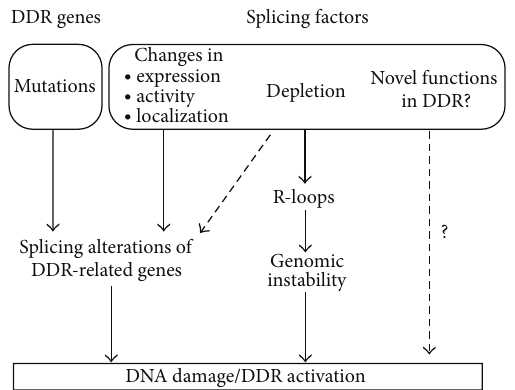
Figure 2: Alternative splicing alterations can activate the DDR. Mutations in splicing regulatory signals can inactivate the function of genes directly involved in the DDR, resulting in the accumulation of DNA damage. However, also the inactivation of canonical splicing factors can have similar effects, either by inducing aberrant splicing of DDR genes or by perturbing cotranscriptional splicing and inducing R-loop formation. However, it cannot be ruled out that AS- and RNA-binding proteins may play novel roles in the DDR and the control of genome